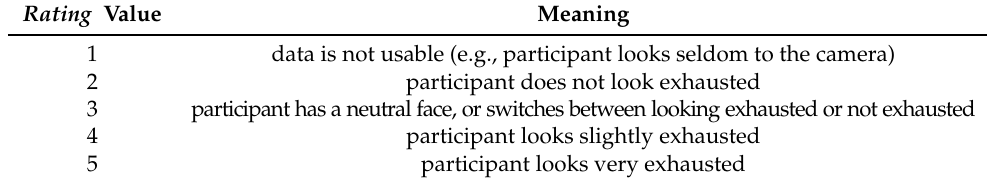
Table 4. Annotation of rating